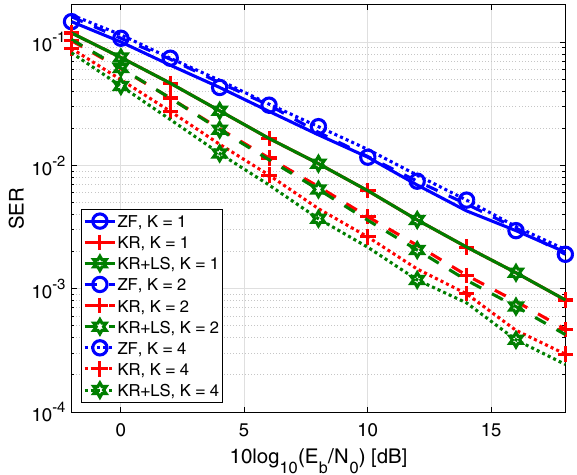
Fig. 3 SER versus E b / N 0 for N = 128 , Q = 2 , M T = 2 , M R = 2 , (cid:31) K = K , (cid:31) F = 4 and different numbers of blocks K